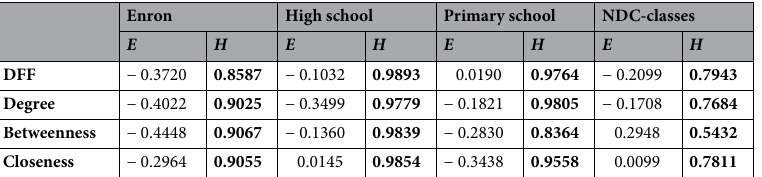
Table 3. Spearman correlation coefficients between the ranking scores and the diffusion indices for edges (E) and higher-order interactions (H). The results are averaged over 100 independent implementations with µ/µ c = 1.5 . The cells for the best value in each row for each dataset is typed bold.